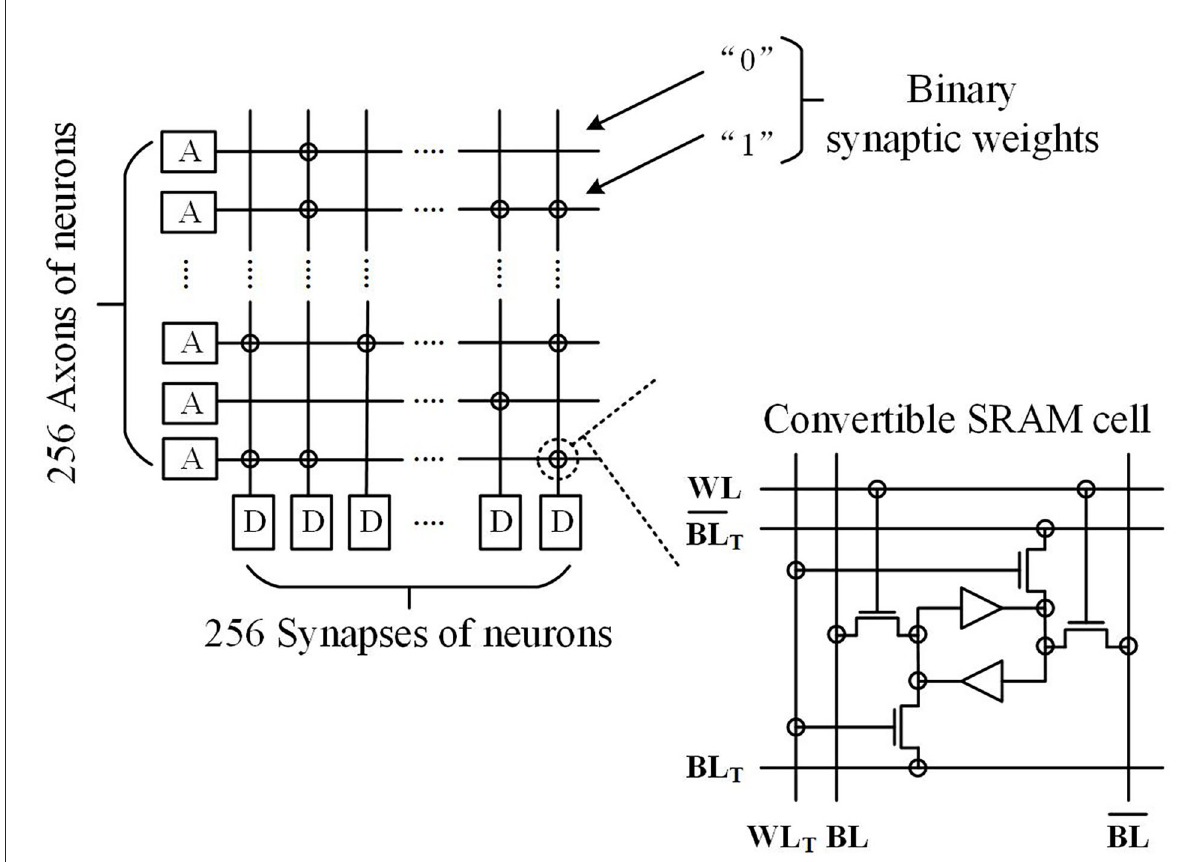
FIGURE7 Neuromorphic synaptic apparatus spiking neural network core